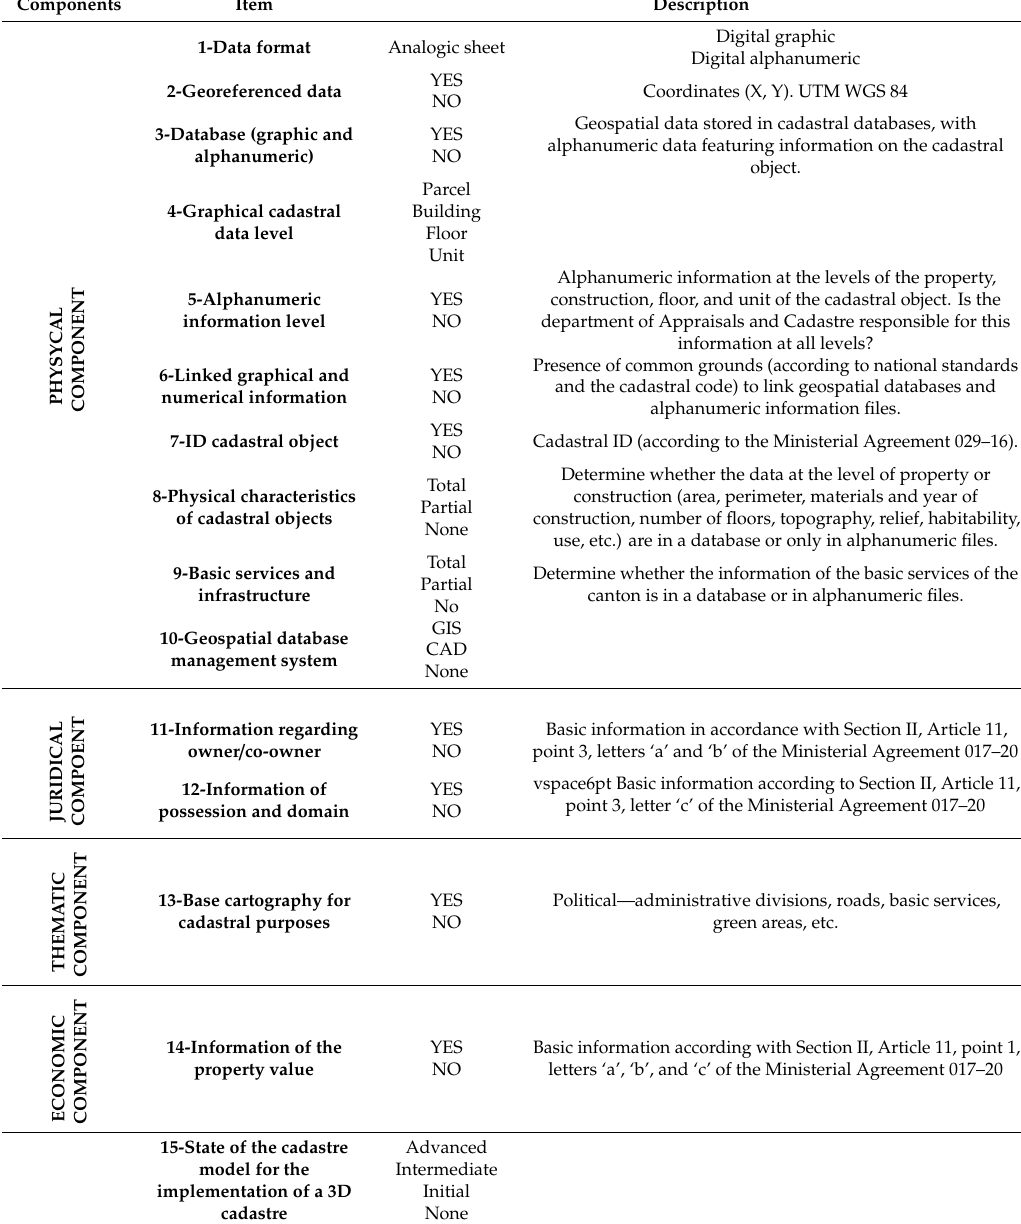
Table 1. Aspects considered in the analysis of the cadastral systems of the selected decentralized autonomous governments